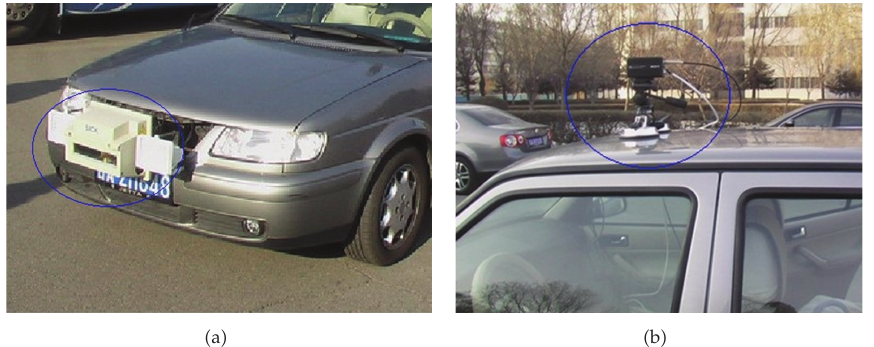
Figure 3: (cid:2) a (cid:3) Installation location of the laser scanner and near-infrared illuminators. (cid:2) b (cid:3) Installation location of the camera.